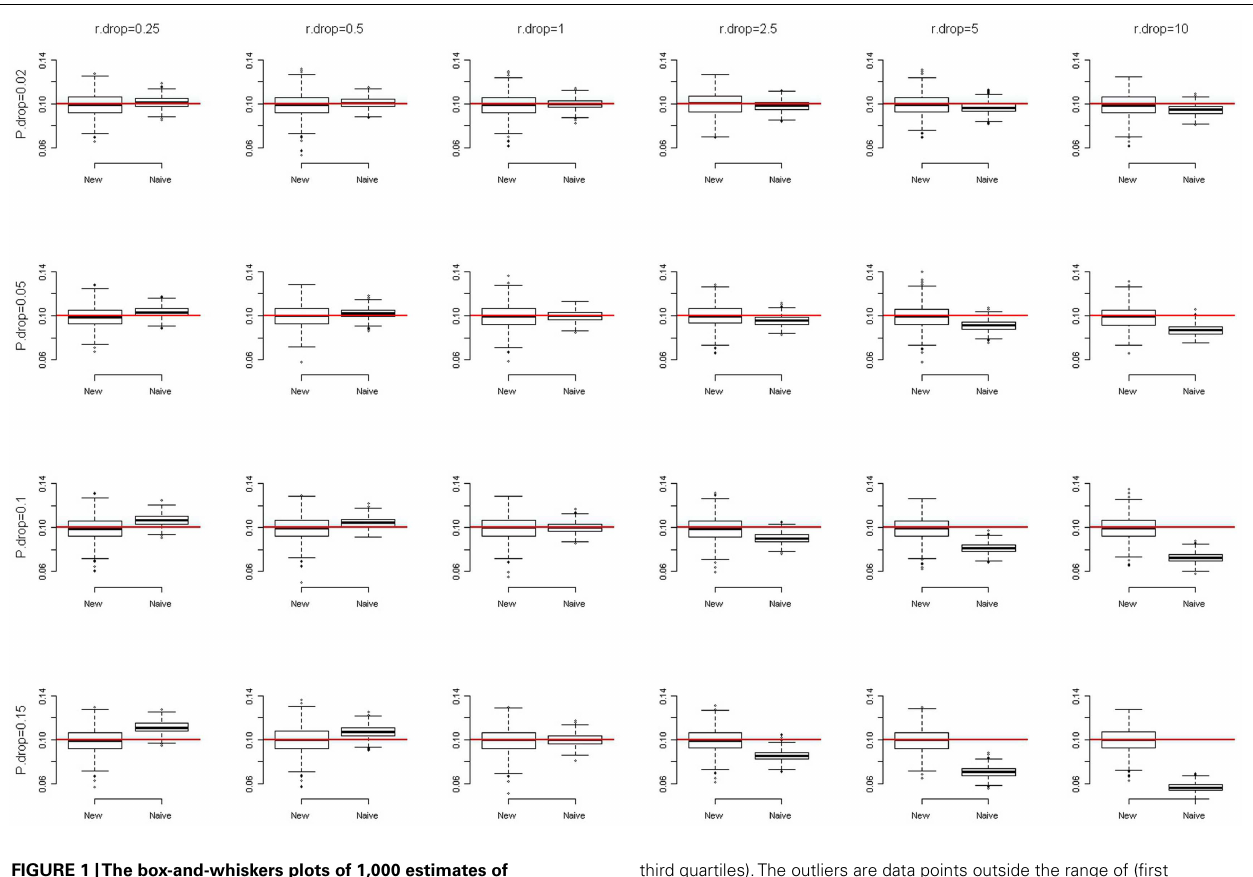
FIGURE 1 |The box-and-whiskers plots of 1,000 estimates of MAF, given MAF = 0.1. The different panels in the figure are arranged so that the overall genotype missing rate (P.drop) is 0.02, 0.05, 0.1, and 0.15 (from top to bottom) and the DDR (r.drop) is 0.25, 0.5, 1, 2.5, 5, and 10 (from left to right). A box is constructed with a median (here, very close to the mean) and two quartiles (the first and the